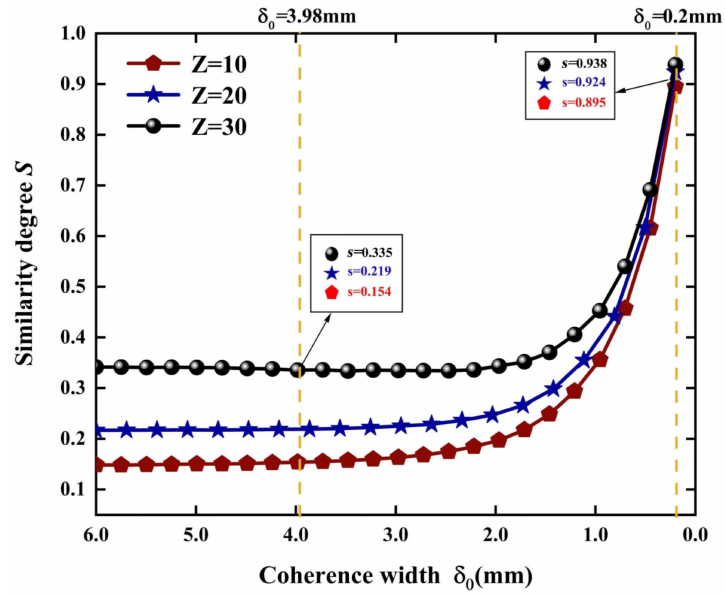
Figure 7. Similarity degree of the PCAB as a function of the coherence width δ 0 , for different prop-agation distances. The different colors represent the different propagation